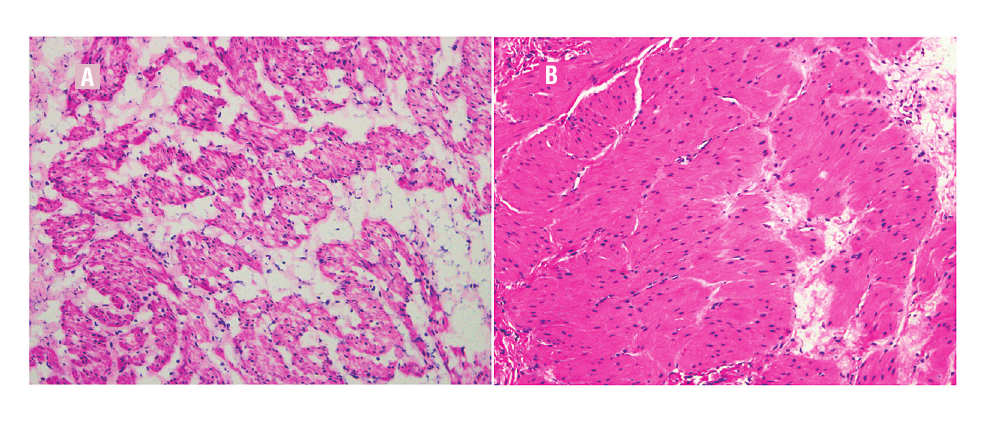
Figure 5 - The frozen section of detrusor muscle cell (h&E staining, x200). a) control group; b) detrusor overactivity group.